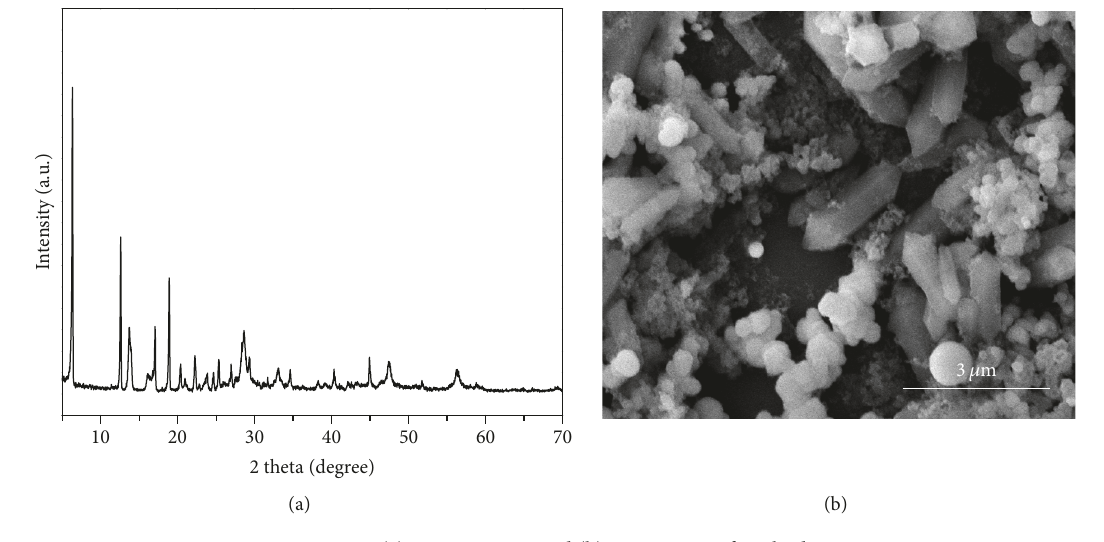
Figure 1: (a) XRD patterns and (b) SEM image of Ce-bpdc.